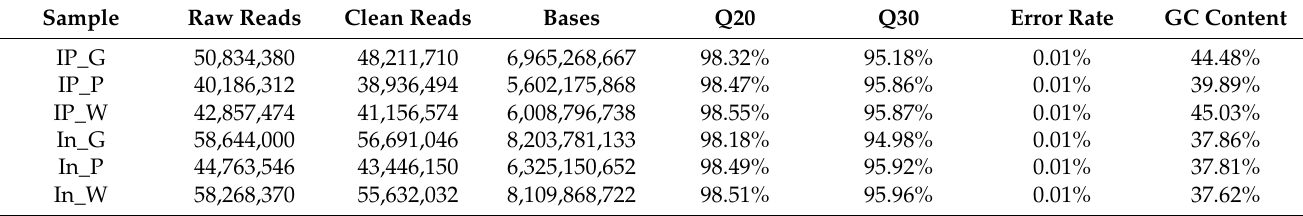
Table 1. Statistical summary of ChIP-seq data